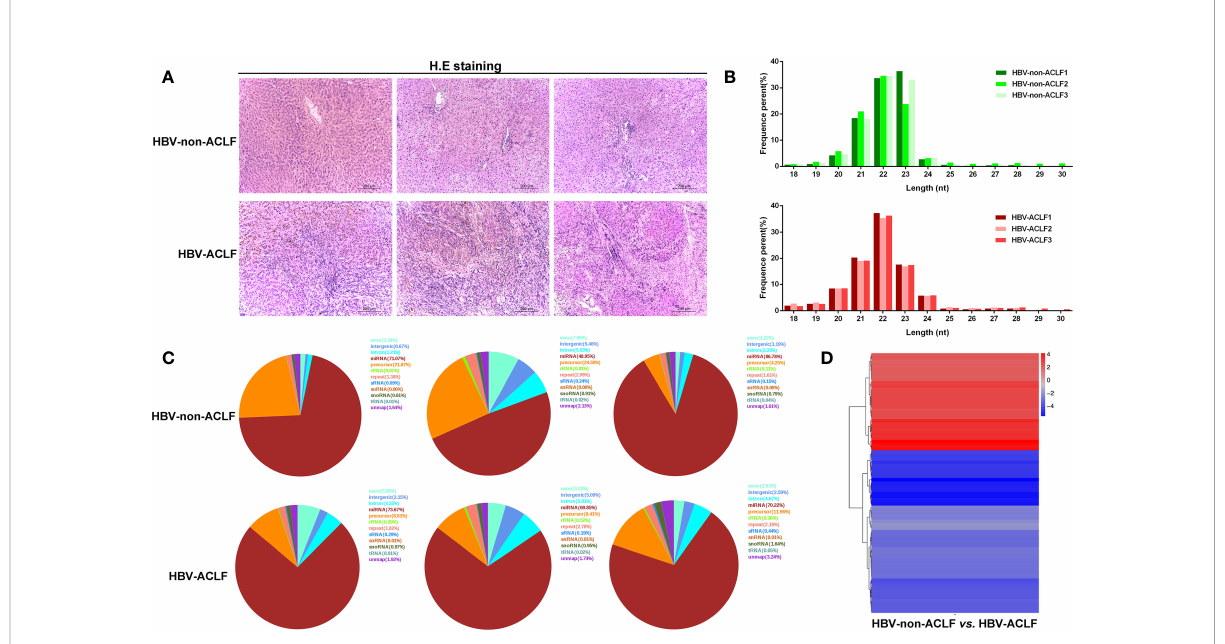
FIGURE 1 Results of high-throughput sequencing and identi fi cation of DE-miRNAs. (A) H&E staining of liver tissues from HBV-non-ACLF and HBV-ACLF groups; (B) Length distribution of the small RNA library; (C) Distribution of small RNAs among different categories; (D) Heatmap of DE-miRNAs constructed by comparing the levels of miRNAs between the two